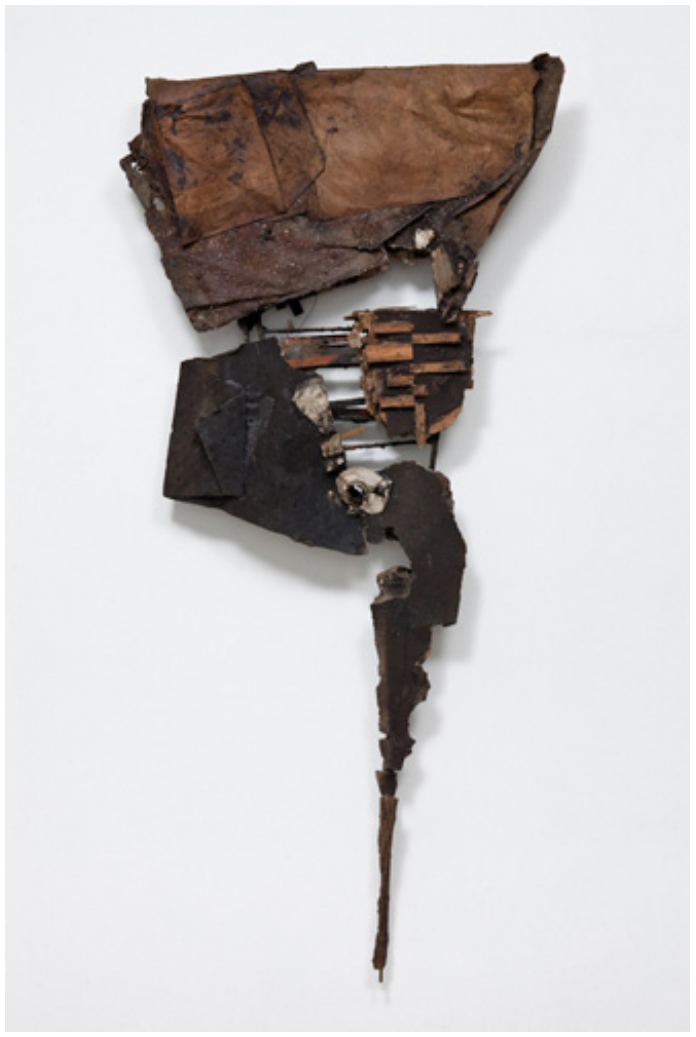
Figure 5. Robert Mallary, Jouster , 1960. Wood, steel, cardboard, tar paper, dirt, resin. Image courtesy of estate of the artist.